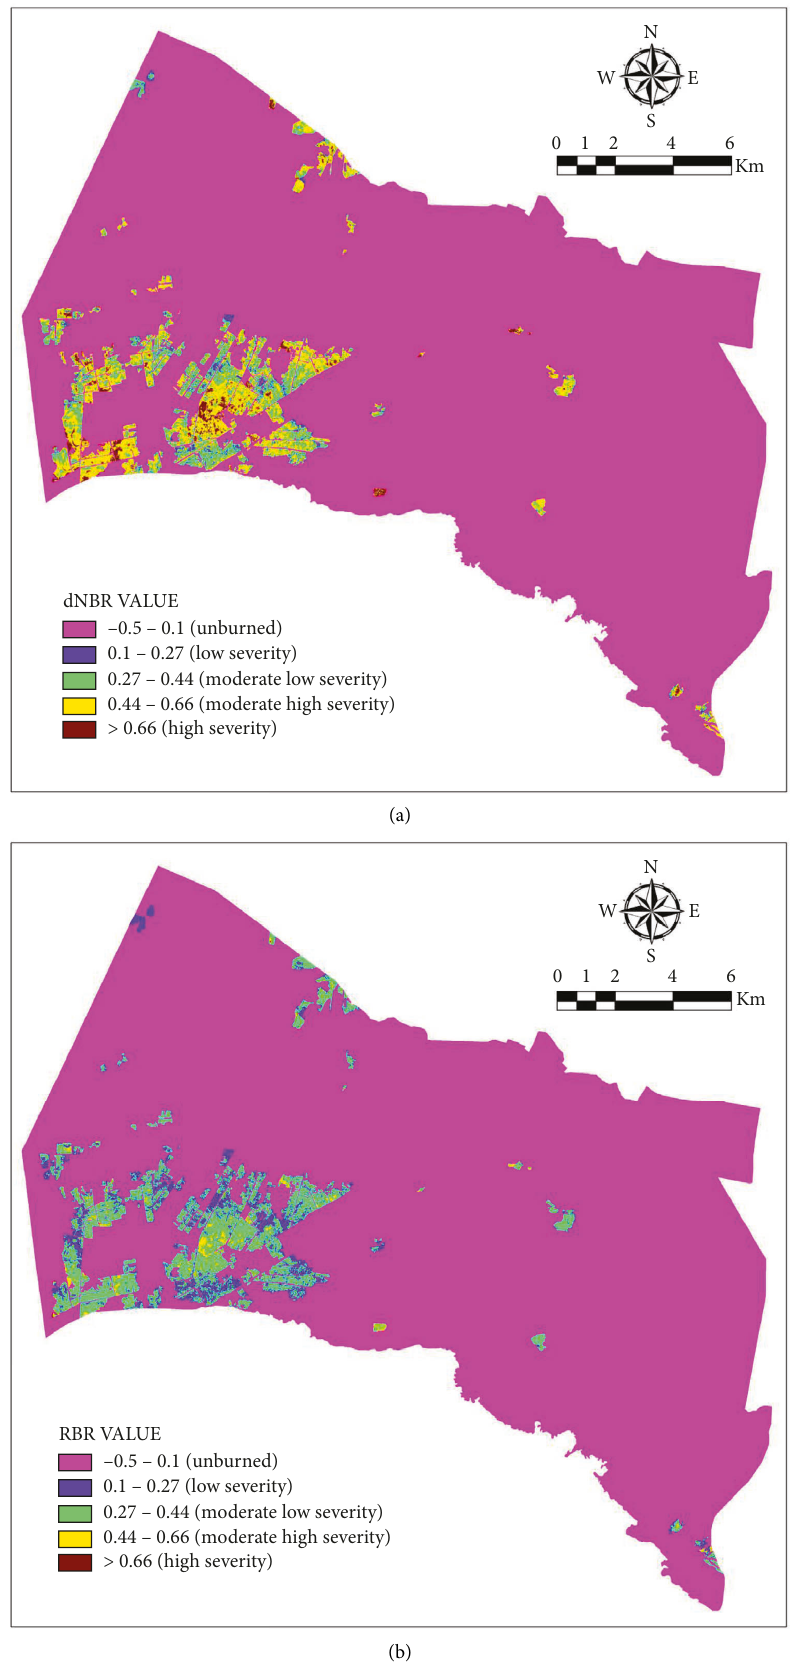
Figure 2: Burned area based on dNBR and RBR values in